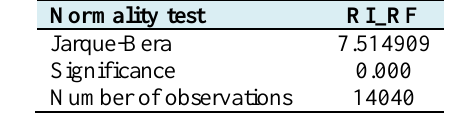
Table 2. Jarque-Bera statistics for research dependent variables